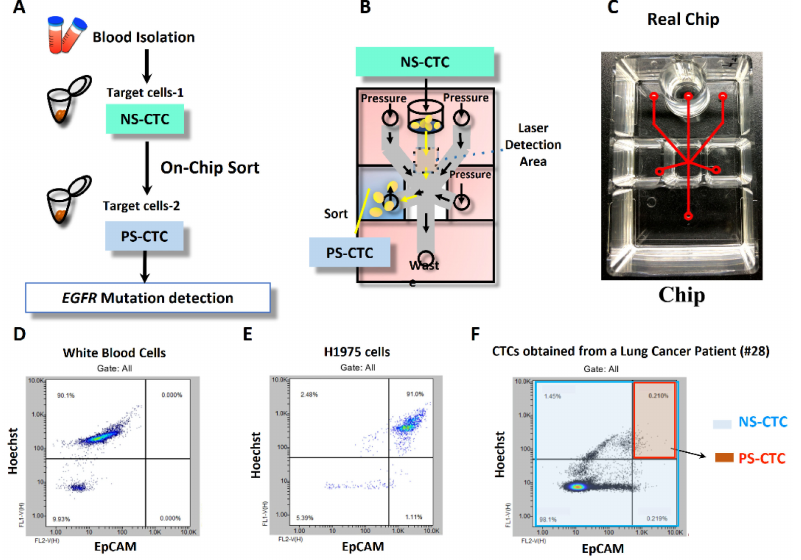
Figure 2. Common protocol for isolating circulating tumor cells and the confirmatory analysis by flow cytometry. ( A ) The workflow of negatively selected circulating tumor cells (NS-CTCs) systems and positively selected circulating tumor cells (PS-CTCs) systems for gene mutation